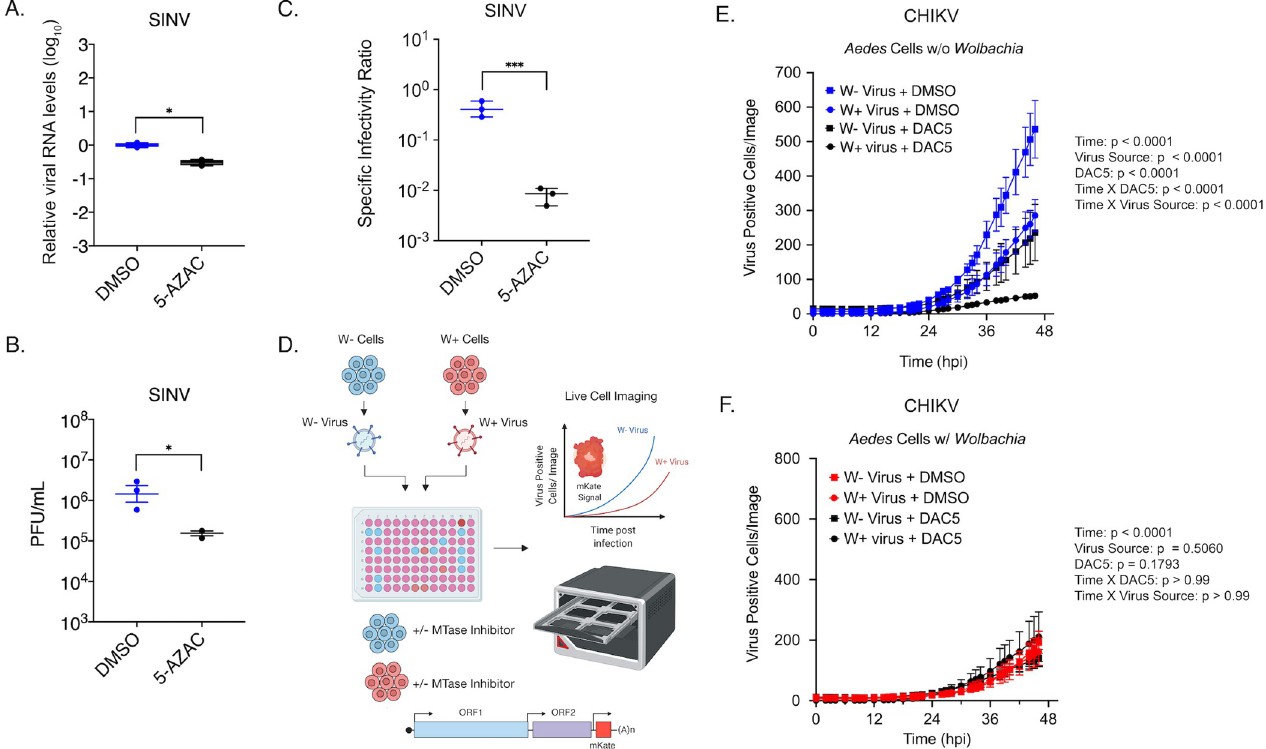
Fig 3. Pharmacological inhibition of mosquito DNMT2 reduces virus replication and per-particle infectivity. Inhibition of mosquito DNMT2 in Wolbachia -free Aedes albopictus derived C7/10 cells was carried out using MTase inhibitors 5-Azacytidine (5-AZAC). Dimethyl-sulfoxide (DMSO) was used as the negative control. In each case, cells were pretreated with 5 μ M inhibitors overnight prior to infections with SINV at MOI of 10. Cell lysates and supernatants were harvested at 24 hours post infection to quantify cellular viral RNA levels and infectious titer, respectively. (A) Levels of SINV RNA in mosquito cells treated with MTase inhibitor 5-AZAC were determined using quantitative RT-PCR. Unpaired two-tailed t-test with Welch’s correction, SINV: p = 0.0012, t = 6.742, df = 4.892. (B) Infectious SINV titers produced from mosquito cells treated with MTase inhibitor 5-AZAC were determined using plaque assays on BHK-21 cells. Unpaired two-tailed t-test with Welch’s correction, SINV: p = 0.0339, t = 4.541, df = 2.322. (C) Specific infectivity ratios of progeny SINV was calculated as the ratio of infectious plaque forming units (B) over total viral genome copies present in collected cell supernatants as quantified by qRT-PCR. Unpaired two-tailed t-test with Welch’s correction, SINV: p = 0.0002, t = 12.59, df = 3.946. Error bars represent standard error of mean (SEM) of three independent experimental replicates. (D) Schematic representation of live cell experiments. CHIKV expressing mKate fluorescent reporter protein was grown in C7/10 Aedes albopictus cells in the presence (W+ virus) or absence (W- virus) of Wolbachia ( strain w Stri). These progeny viruses were then used to infect na ï ve C7/10 cells without (E) and with (F) Wolbachia ( strain w Stri) pretreated with MTase inhibitor or DMSO synchronously at a MOI of 1 particle/cell. Virus growth in cells was measured in real time by imaging and quantifying the number of red cells (Virus Positive Cells/Image) expressing the virus encoded mKate protein over a period of forty-eight hours, using live cell imaging. Color of the data points distinguish treatment conditions; blue represent C7/10 Wolbachia- free cells treated with DMSO, red represent C7/10 Wolbachia- colonized cells treated with DMSO, black represent both C7/10 cell types treated with 5 μ M DAC5. Shape of data points represent the progeny virus type used to initiate infection; boxes represent viruses derived from W- cells, circles represent viruses derived from W+ cells. The Y-axis label red object count/Image represent virus-positive cells in a single field of view, four of which were collected and averaged/sample at each two-hour time point over the course of infection. Three-way ANOVA with Tukey’s post hoc test for multivariate comparisons. Error bars represent standard error of mean (SEM) of independent experimental replicates (n = 3). Three-way ANOVA with Tukey’s multivariate analyses, DAC5: p = 0.1793, Virus Source: p = 0.5060, Time: p < 0.0001, DAC5 X Time: p > 0.99, Virus Source X Time: p > 0.99, Virus Source X DAC5: p = 0.1039, Virus Source X DAC5 X Time: p = 0.9804 (Fig 3E). � P < 0.05; �� P < 0.01, ���� P < 0.0001. Three-way ANOVA with Tukey’s multivariate analyses, DAC5: p < 0.0001, Virus Source: p < 0.0001, Time: p < 0.0001, DAC5 X Time: p < 0.0001, Source X Time: p < 0.0001, Virus Source X DAC5: p = 0.1148, Virus Source X DAC5 X Time: p > 0.999 (Fig 3F). Graphical assets were made in BioRender